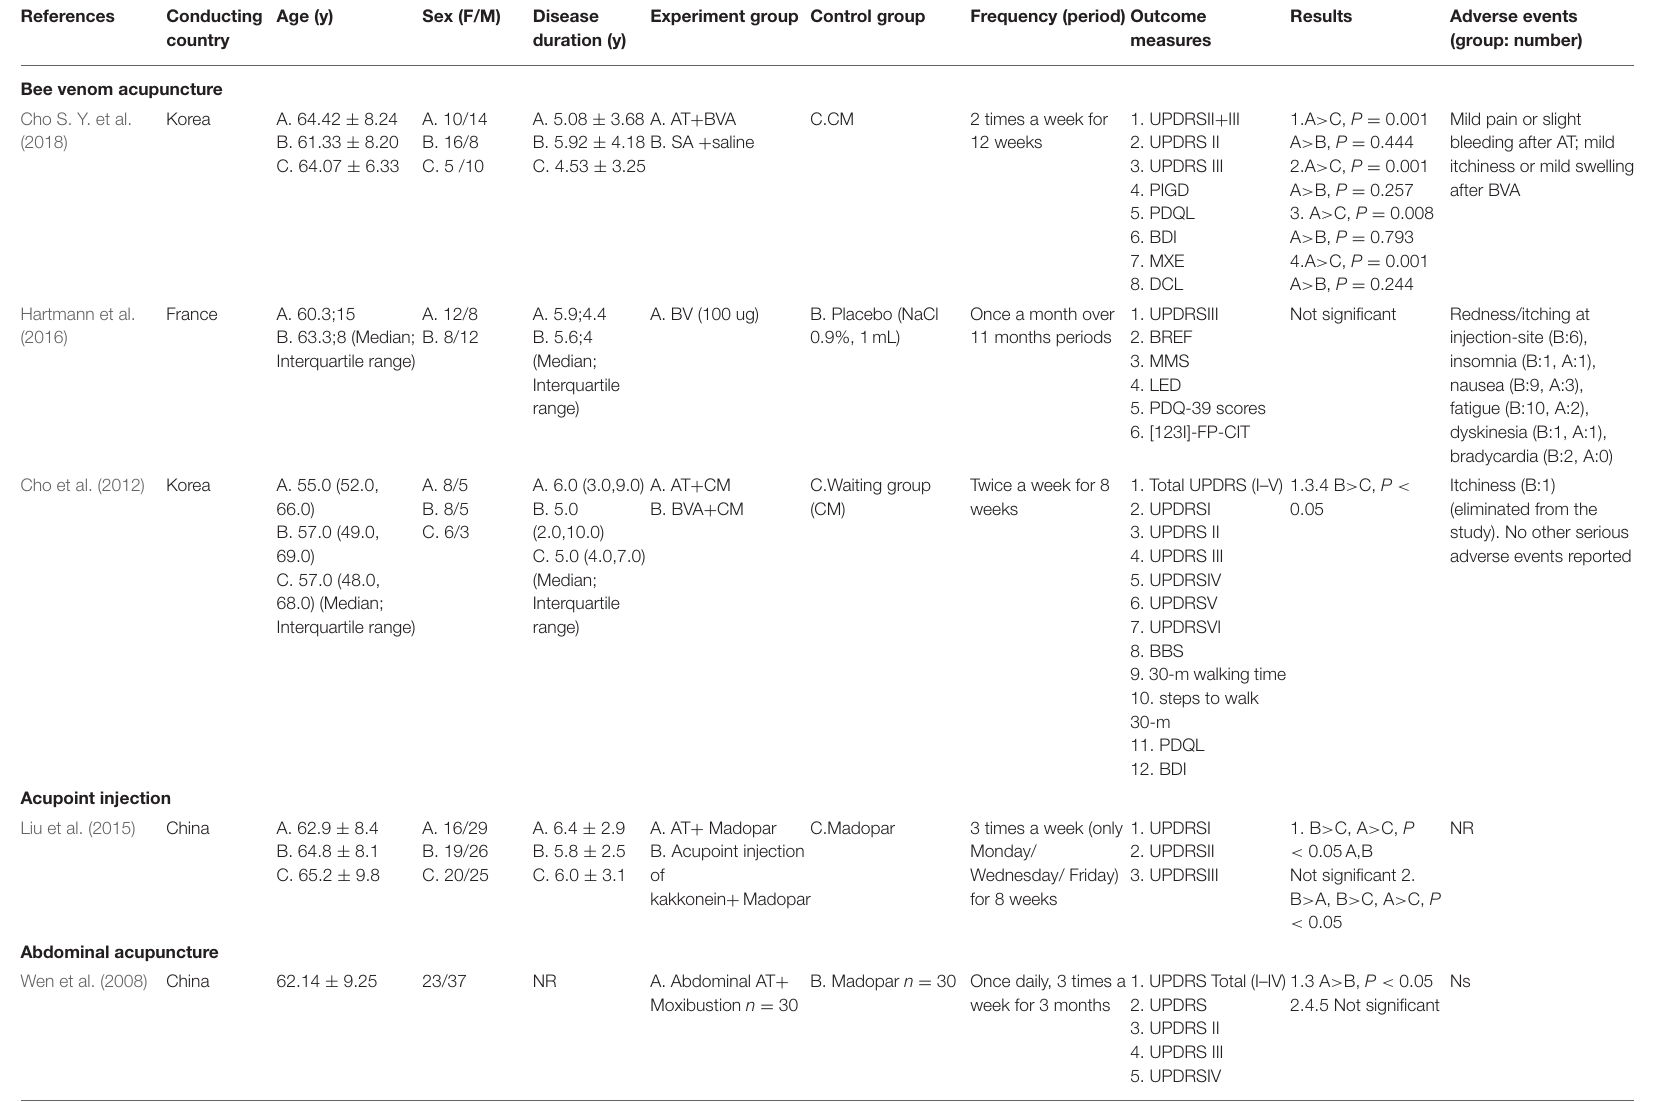
TABLE 1 | Characteristics of the included clinical trials involving acupuncture related therapy of Parkinson’s